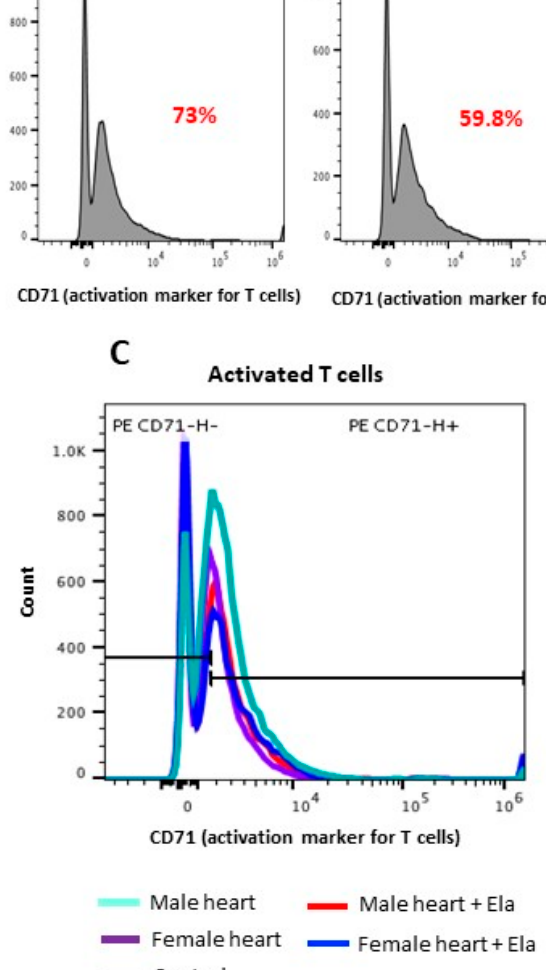
Figure 2. Elabela could suppress T-cell activation. T-cell activation was measured in an MLR assay using male ( A ) and female ( B ) cardiac cells as stimulators versus splenic T cells as responders. Using flow cytometry, CD71-expressing T cells were identified and quantified as T-cell activation markers. ( C ) Histogram panel depicting the comparative analysis of activated T cells in males versus